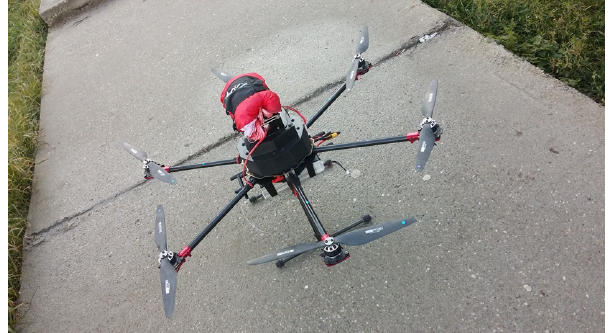
Figure 4. Hexa-rotor aerial copter